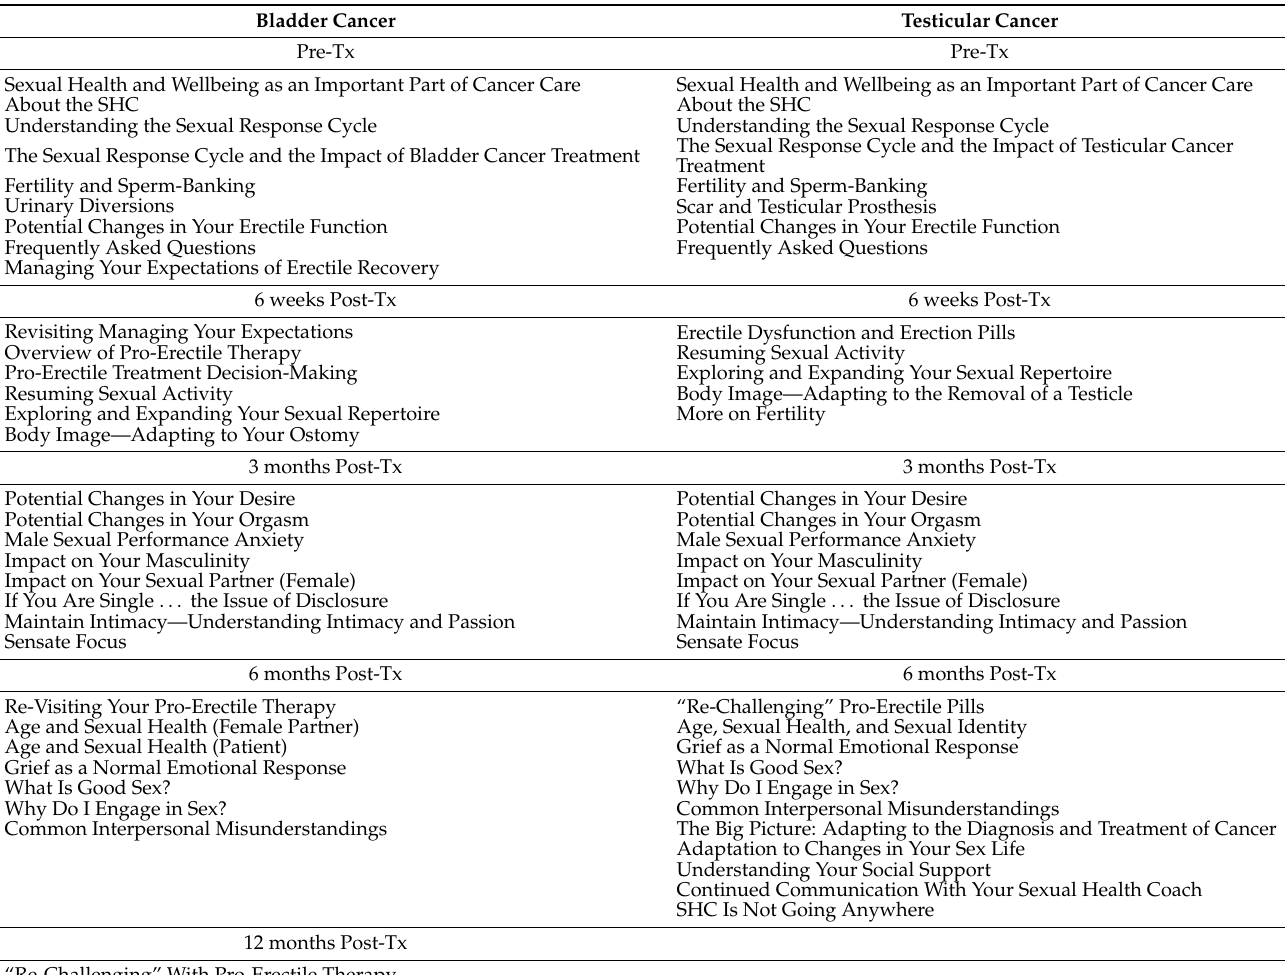
Table 2. Example of Unique Patient